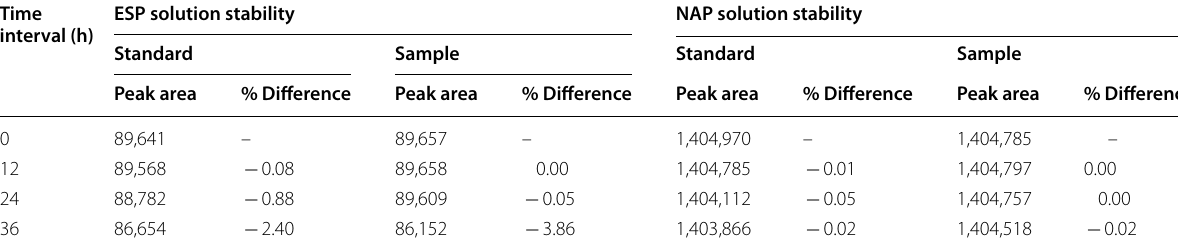
Table 8 Data for solution stability analysis